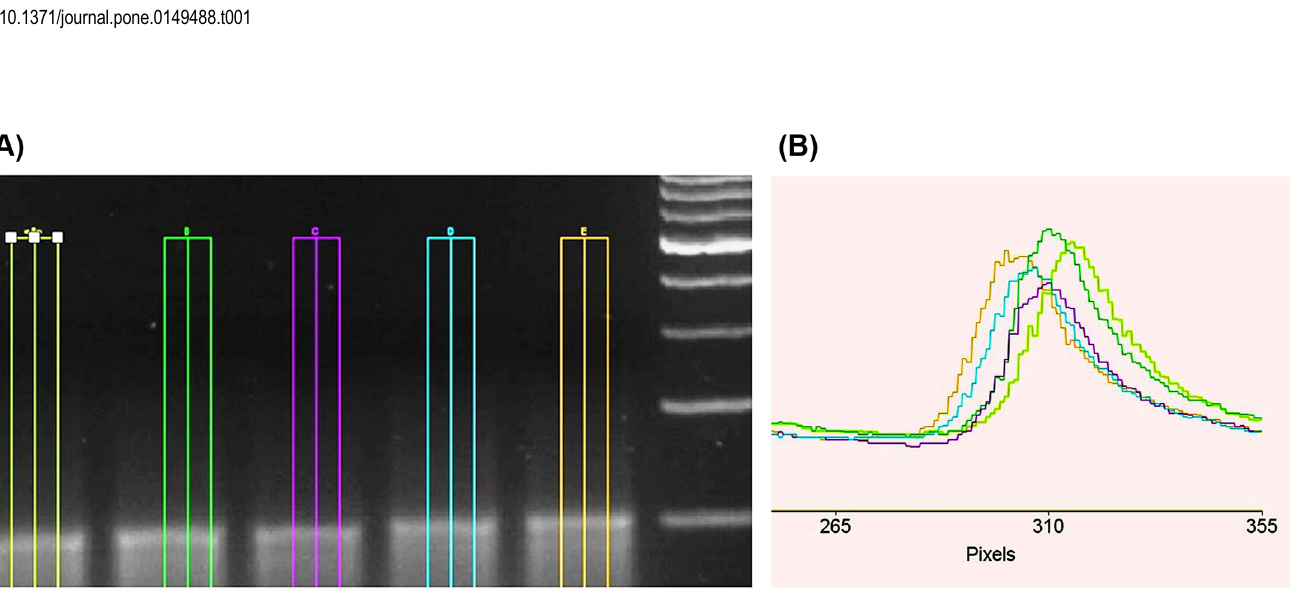
Fig 2. Gel electrophoresis image and analysis. (A) shows the gel electrophoresis image of five samples of CG 100 after exposure to the magnetic field (0, 250, 500, 750, and 1000 mT) based on their displacement (d1, d2, d3, d4, and d5), respectively, and Fig 2B shows the analysis of CG 100 displacement in the gel by evaluation of the intensity of the lane and lane